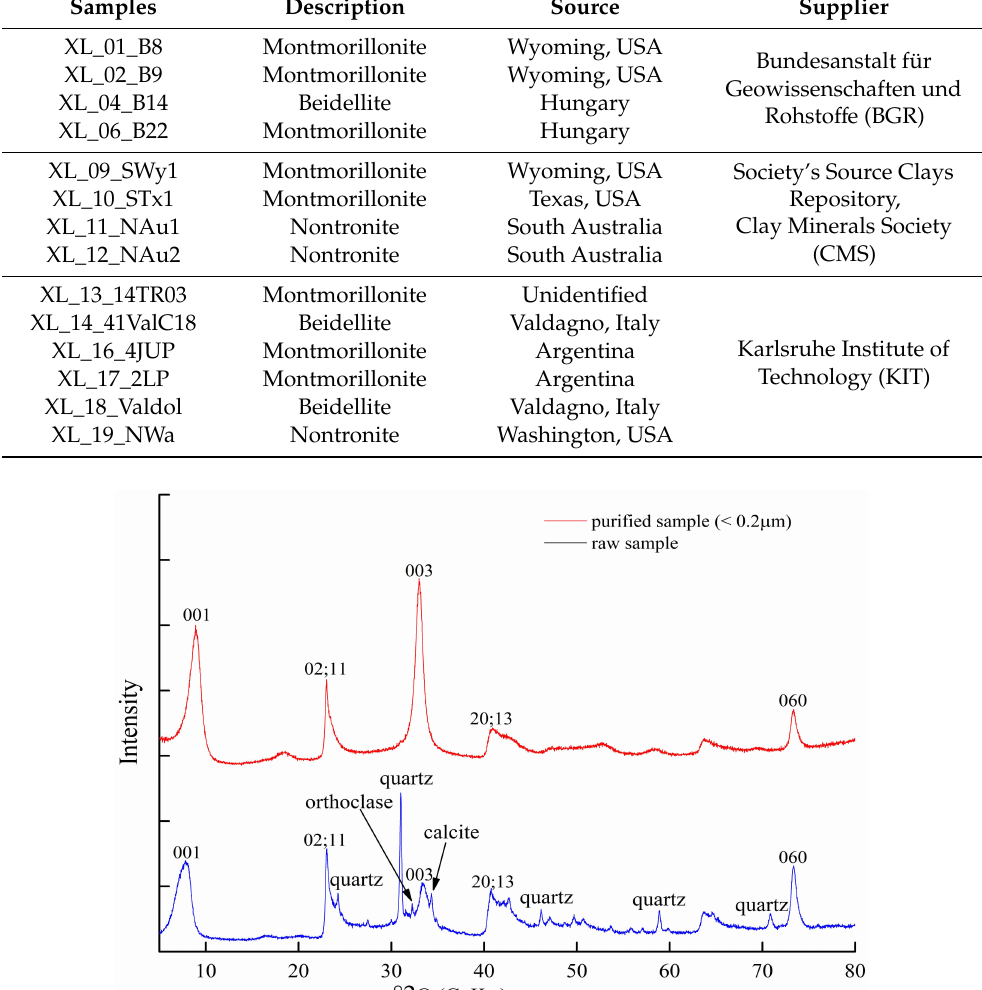
Figure 4. X-ray powder di ff raction (XRD) patterns of Sample XL_09_ SWy1 before and after